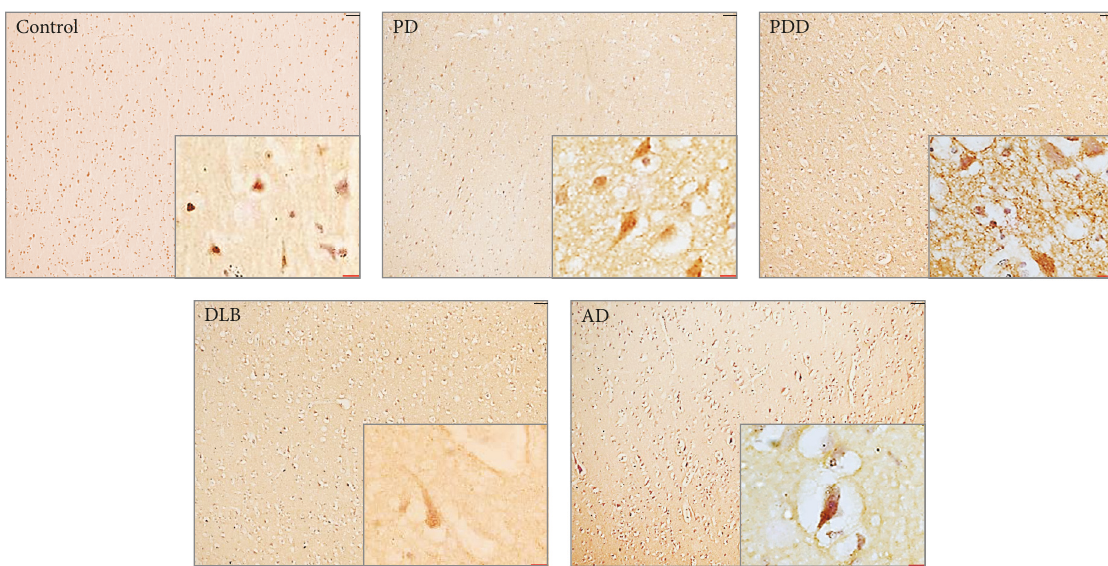
Figure 11: Cellular distribution of SIRT2 in the temporal cortex of disease and control groups. The images show the cellular localisation of SIRT2 in grey matter of superior temporal gyrus of temporal cortex in PD, PDD, DLB, AD, and control cases. SIRT2 was localised in both in the cytoplasm and the nucleus of the neurones in the groups, being predominantly present in the cytoplasm in AD. The picture in inset is 63x oil immersion image overlaid on 10x image. Scale bars, black scale bar = 50 𝜇 M and red scale bar = 20 𝜇